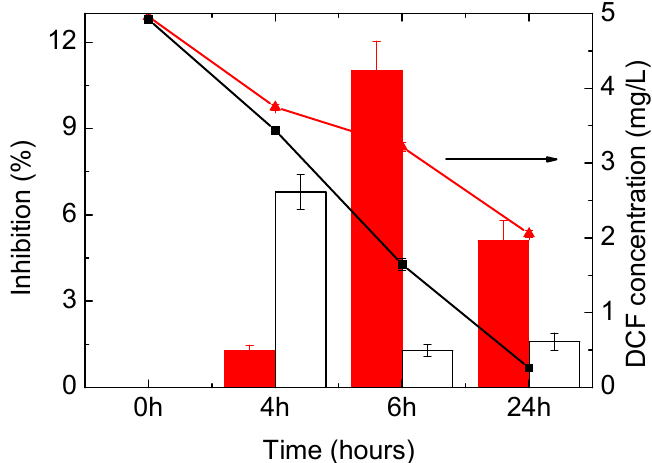
Figure 6. Acute toxicity on mutant bacteria using the Toxi-ChromoTest kit. Red and white bars refer to photolysis and photocatalysis experiments, respectively; the values should be read on the left axis. DCF concentration is reported for both experiments on the right axis—red and black curves respectively. Error bars refer to standard deviation of quadruplicate measurements of combined duplicate samples.